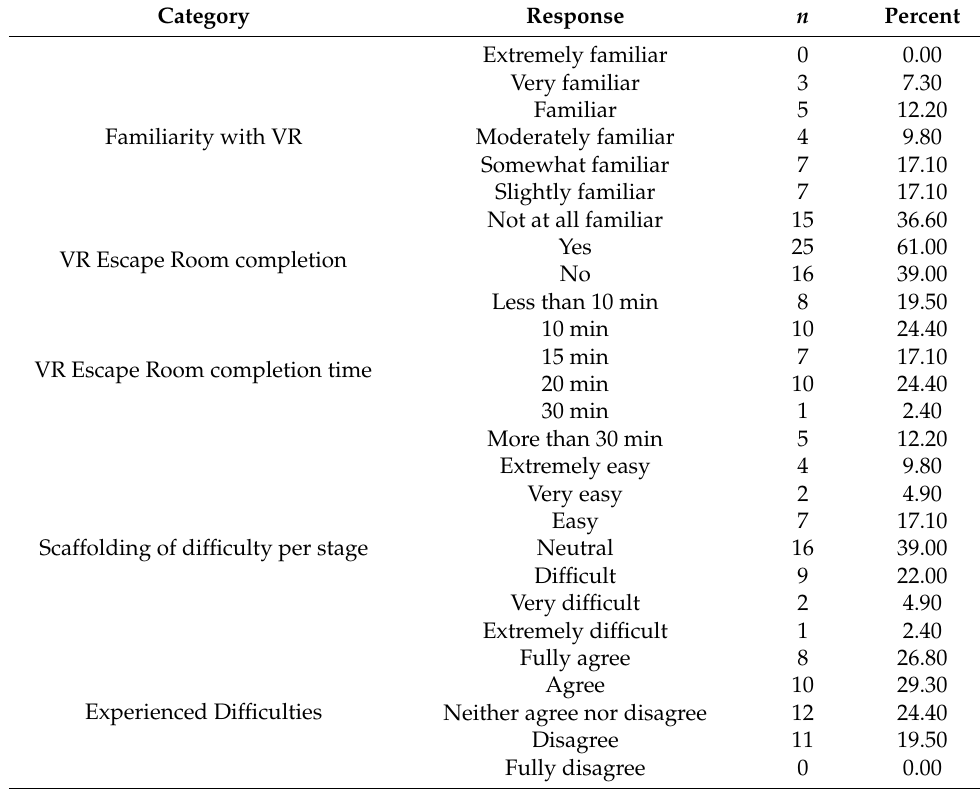
Table 2. Multifactor assessment of the virtual reality escape room experience.